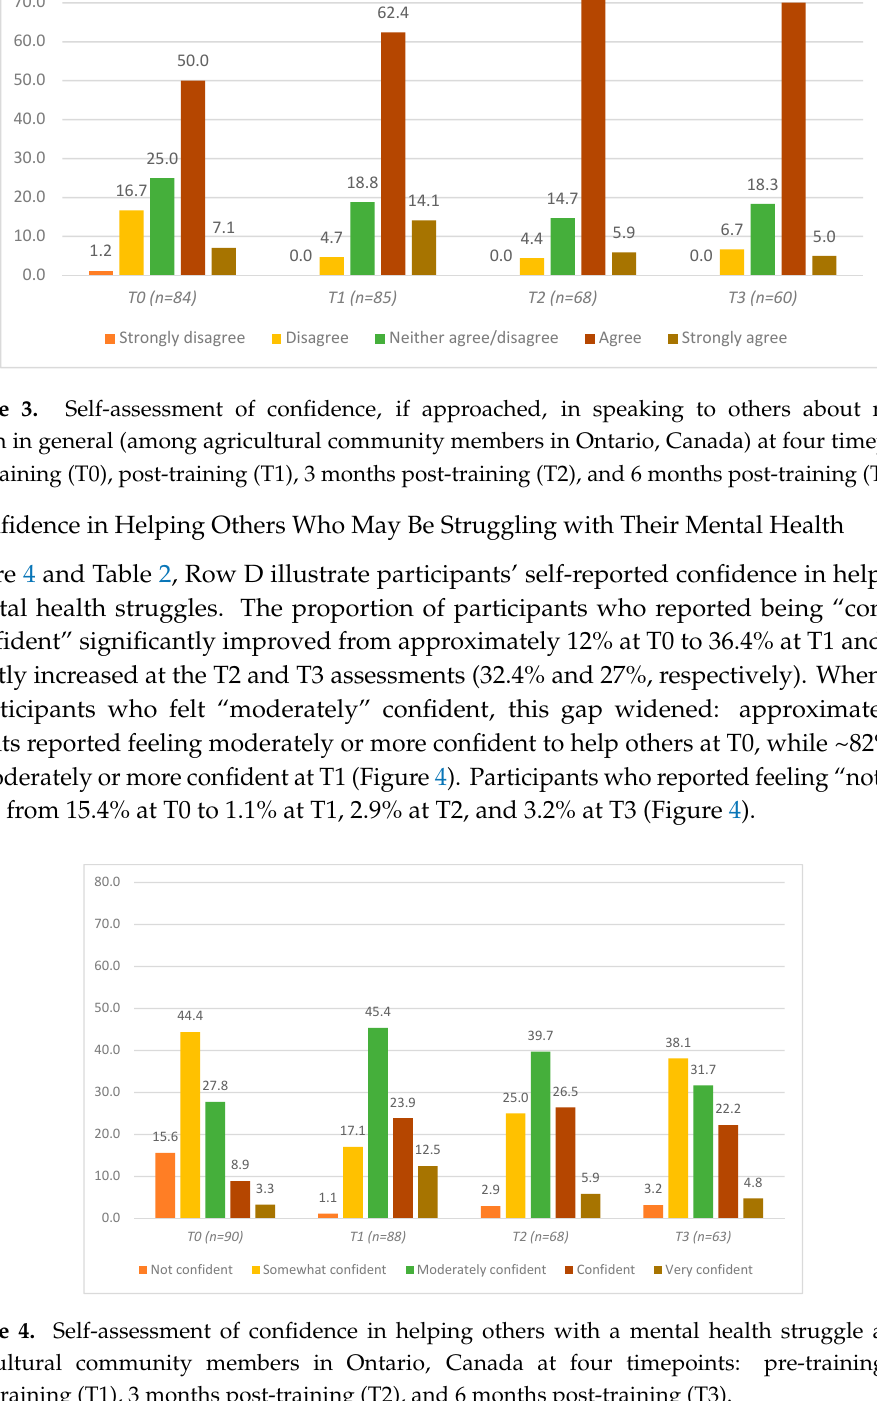
Figure 2. Self-assessment of confidence in recognizing signs and symptoms of mental health struggles post-training (T1), 3 months post-training (T2), and 6 months post-training (T3).